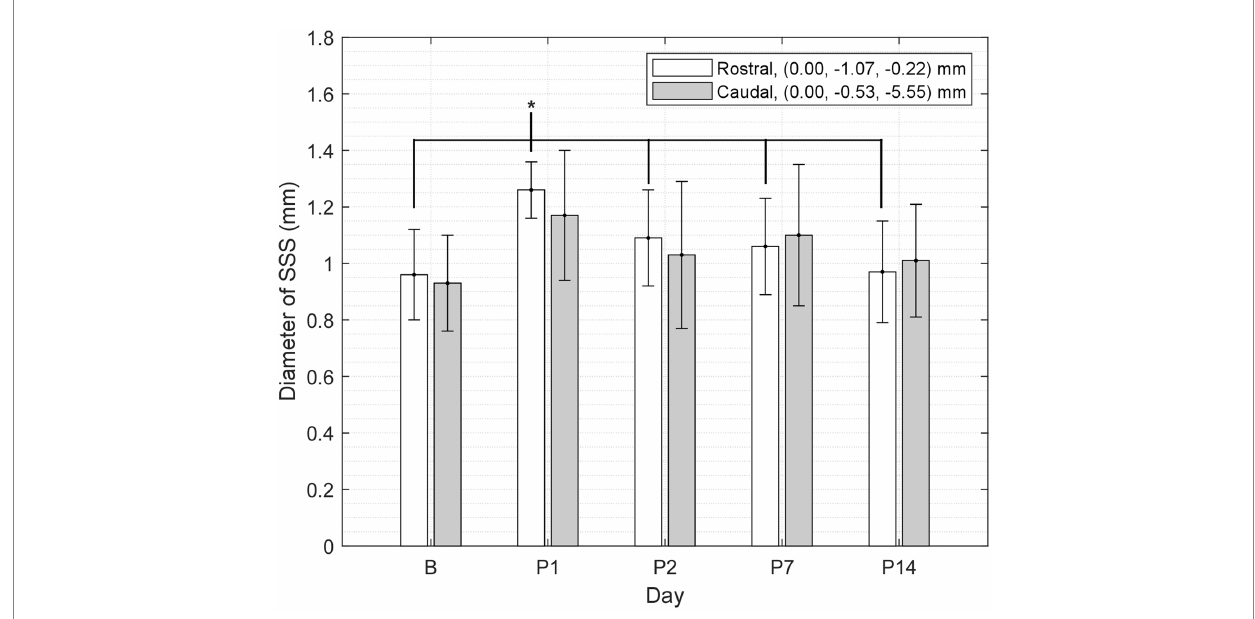
FIGURE 4 Diameter of the SSS at two points (rostral and caudal) measured in a mid-sagittal slice of the T1W GRE + Gd difference images grouped by day (mean ± SD). At the rostral point, P1 was greater than B and P2–14 (where * indicates p <